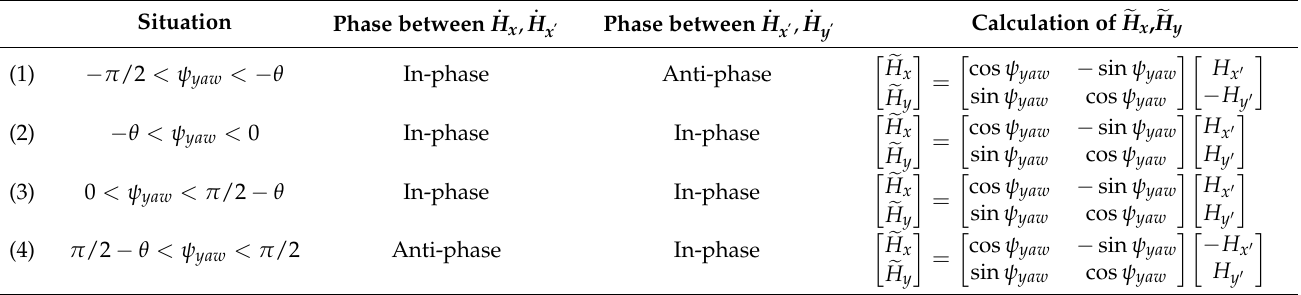
. . H x (cid:48) and H y (cid:48) , and the calculation of